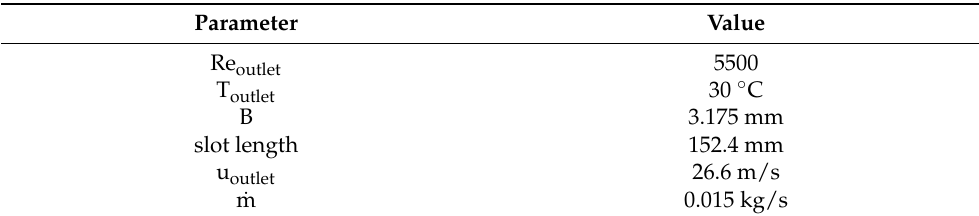
Table 4. Fundamental parameters of the multi slot jet configurations.